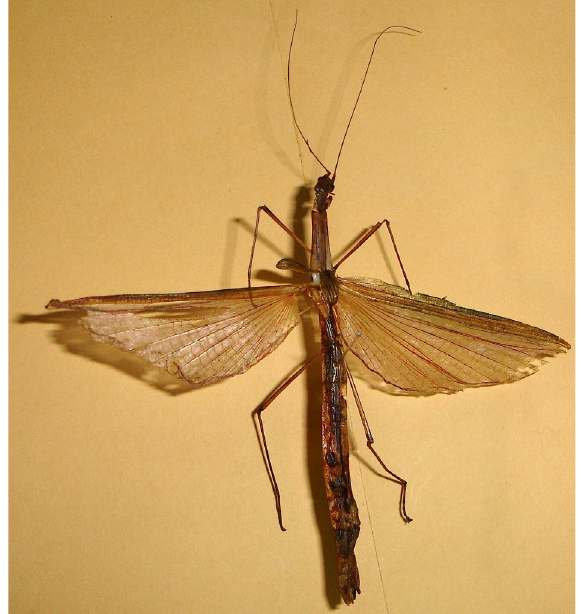
Image 4. Forewing.